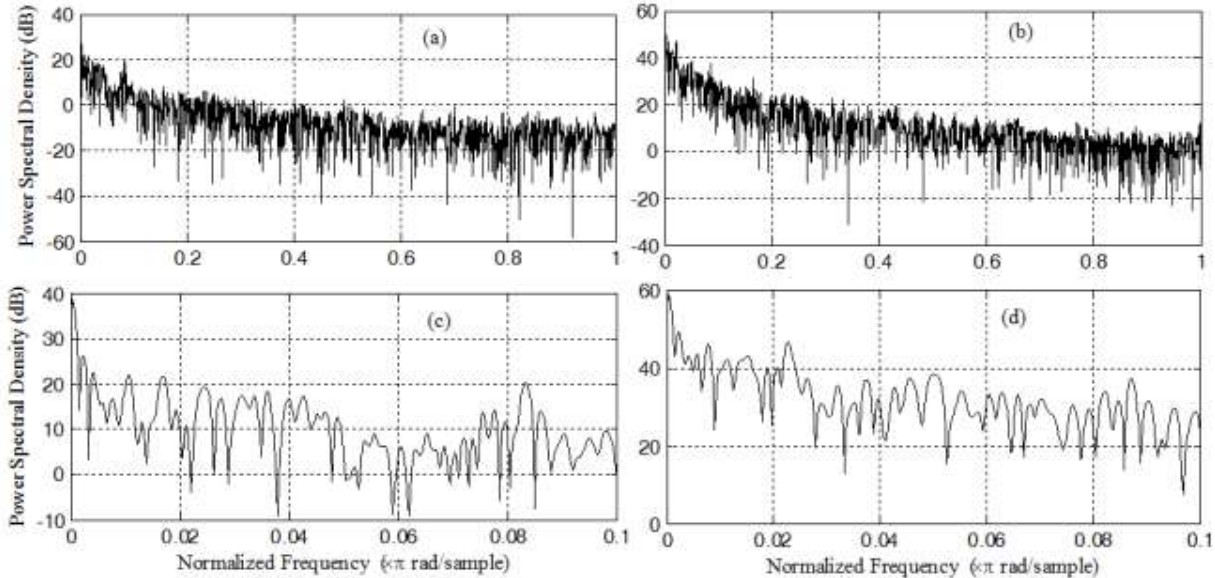
Figure 3. Power spectral density for (a) The wind speed, (b) The wind power, (c) and (d) Figs. 3(a) and 3(b) zoomed out.